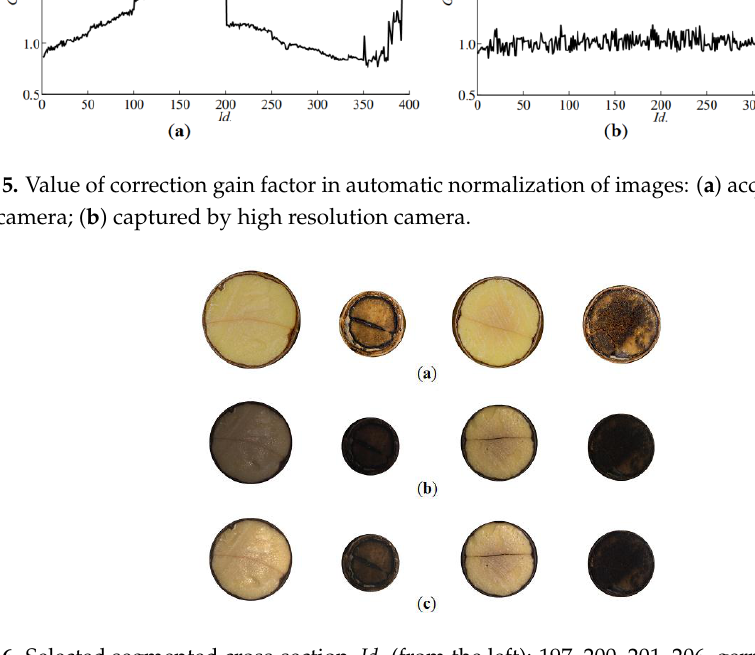
Figure 6. Selected segmented cross-section, Id. (from the left): 197, 200, 201, 206, germinating: 197, 201; non-germinating: 200, 206: ( a ) images of sections captured by high resolution camera; ( b ) images of sections captured by machine vision camera; ( c ) normalized images.